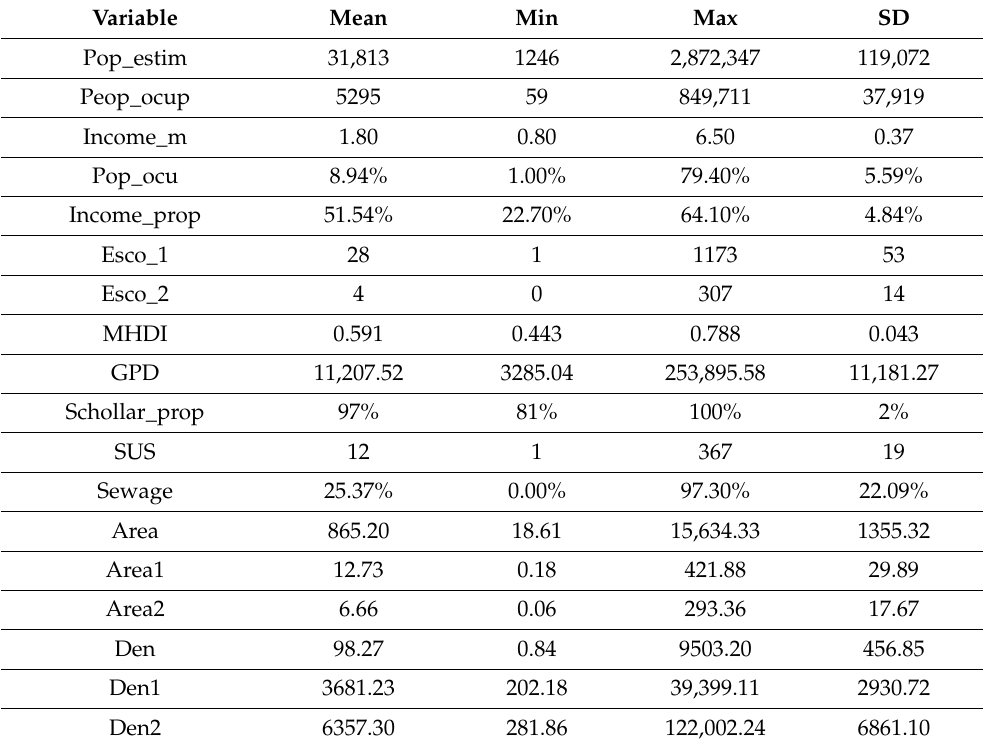
Table 4. Descriptive features.